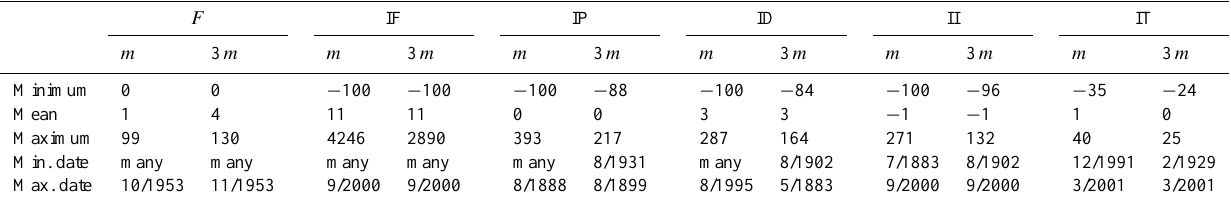
Table 2. Statistics of the monthly time series of floods ( F) and the indexes of floods (IF), precipitation (IP), wet days (ID), precipitation intensity (II), and temperature (IT). m : 1-month time series, 3 m : 3-month time series. F IF